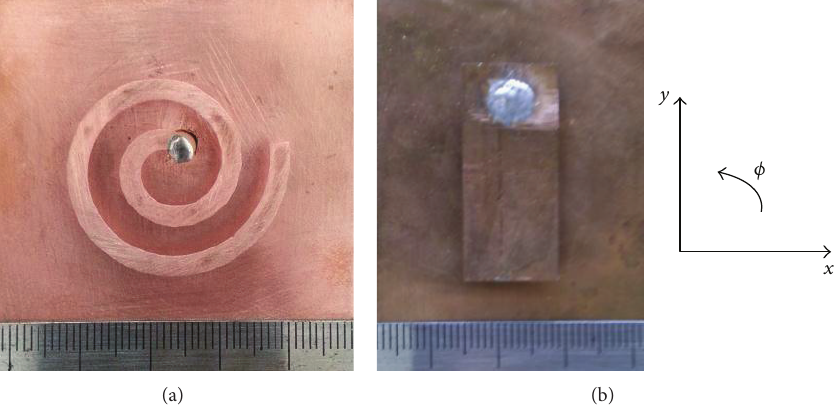
Figure 1: Top view of the spiral (a) and patch (b)